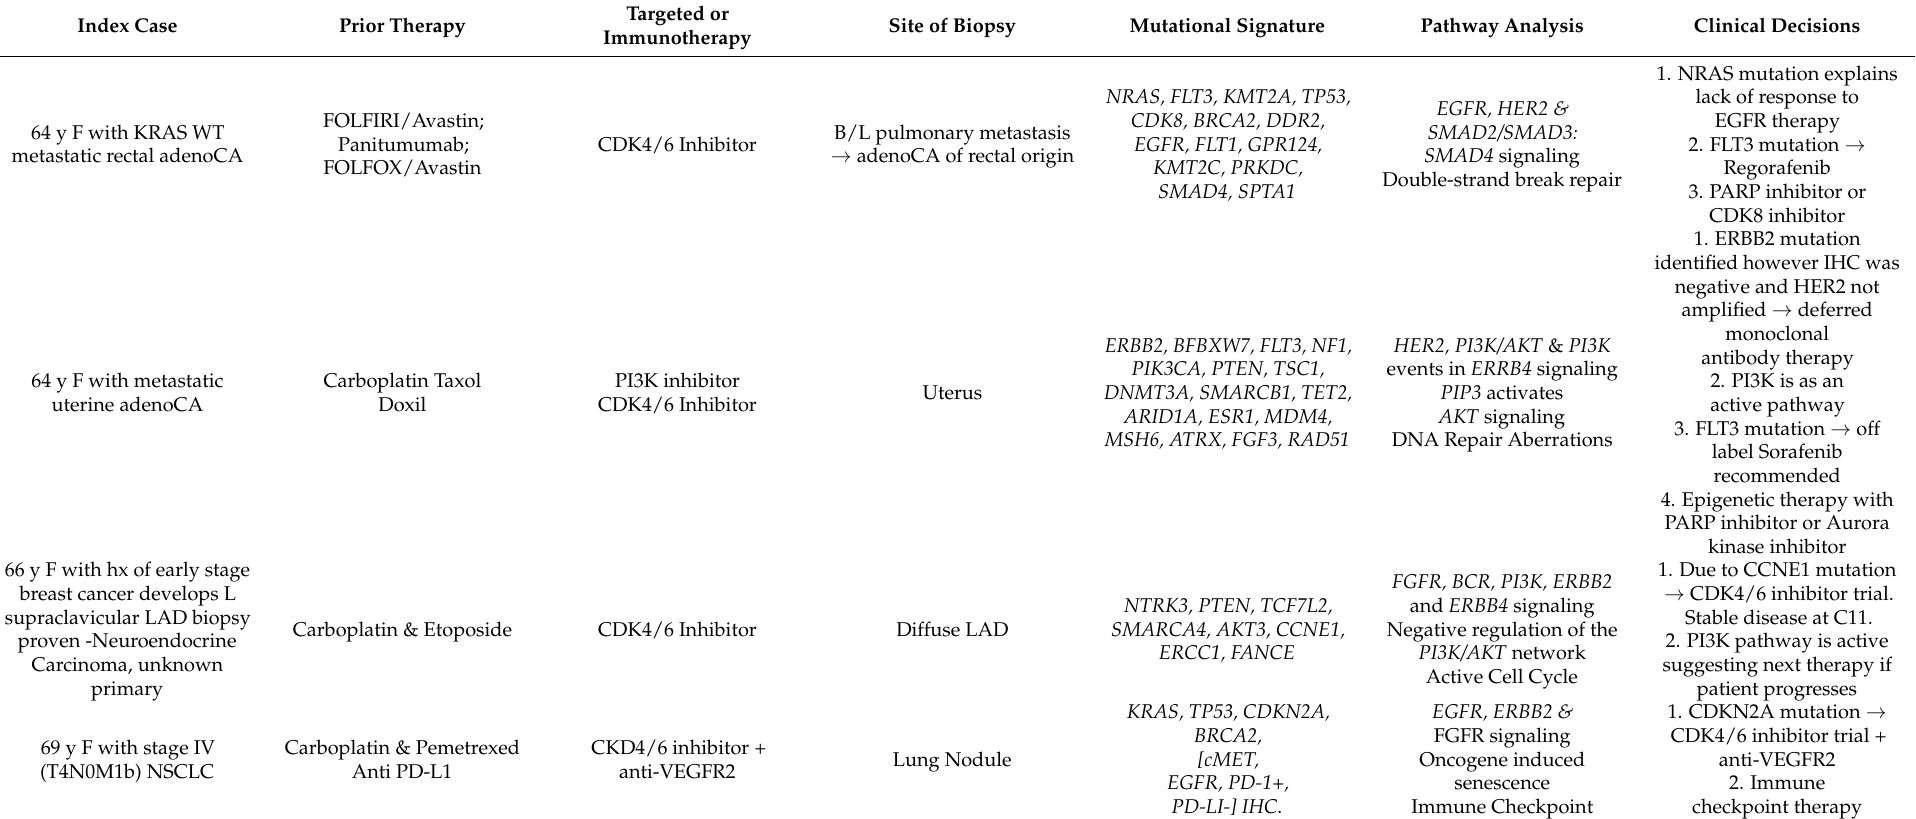
Table 5. Mutational signatures and pathway analysis of pre- and/or post- targeted therapies individualized in advanced cancer patients entering phase I therapeutic